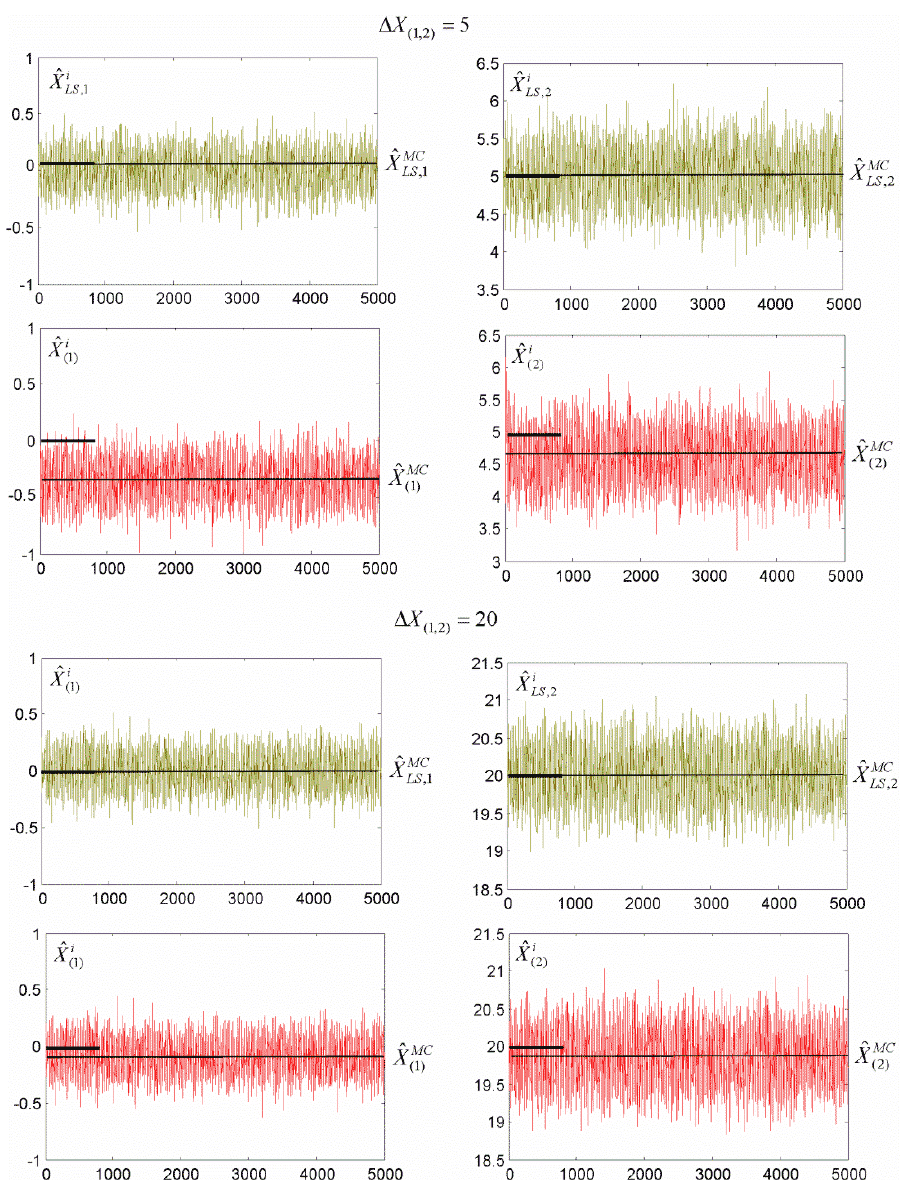
Figure 3. Location of the Monte Carlo estimates for ∆ X ( 1,2 ) = 5 or ∆ X ( 1,2 ) = 20 (for N =